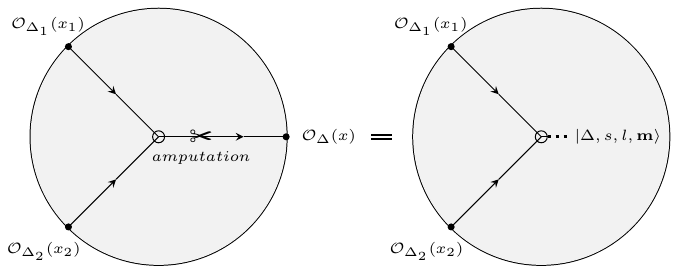
Figure 4 . OPE module from 3-point function.